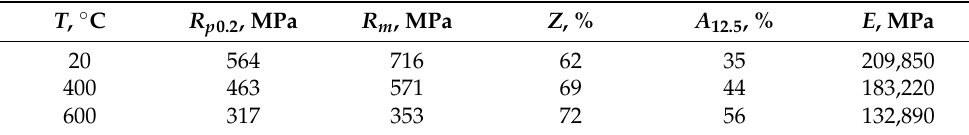
Table 2. Strength parameters of P91 steel at different temperatures.